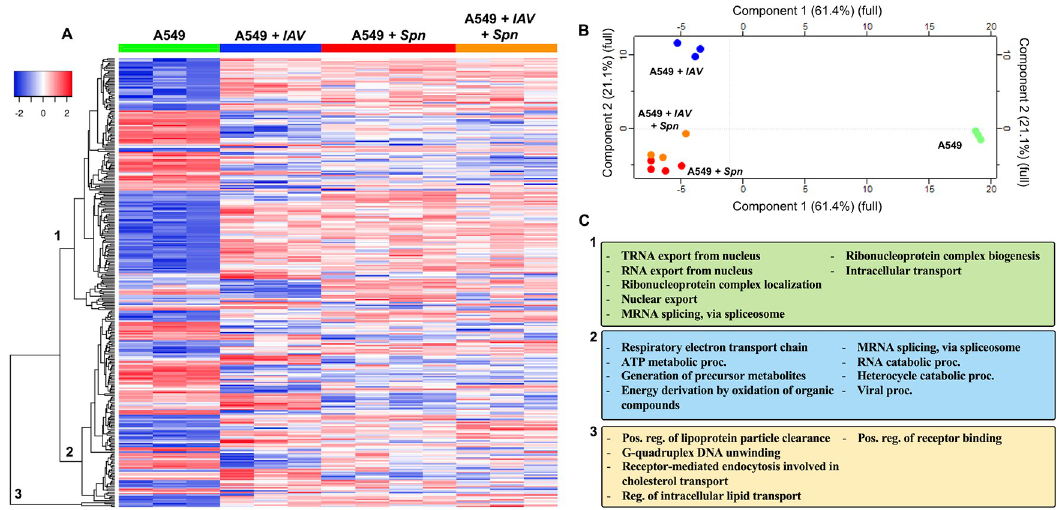
Fig 8. Sequential infection of RECs with IAV and Spn leads to differential proteomic remodeling. A549 respiratory epithelial cells were infected with IAV PR8 at an MOI of 2. Four hours post infection, cells were challenged with Spn at an MOI of 10 for an additional four hours. As a control, A549 cells were grown in tissue culture media withour exposure to any pathogen. Proteomic changes in A549 cells. ( A ) Hierarchical clustering of label-free quantification (LFQ) intensities of significantly changed proteins (ANOVA, P � 0.05) revealed 3 distinct clusters. Their abundance profiles among the groups were plotted in the heatmap. ( B ) Principal component analysis denoting differences in Spn proteomic profiles. ( C ) Enriched GO biological process terms are indicated for each marked